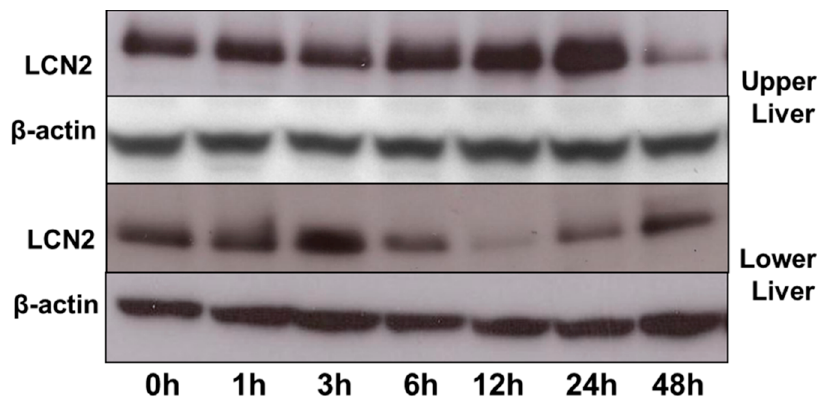
Figure 7. Western blot analysis of LCN2 (25 kDa) protein in the upper and lower part of the liver. β -actin (42 kDa) was used as the internal loading control.